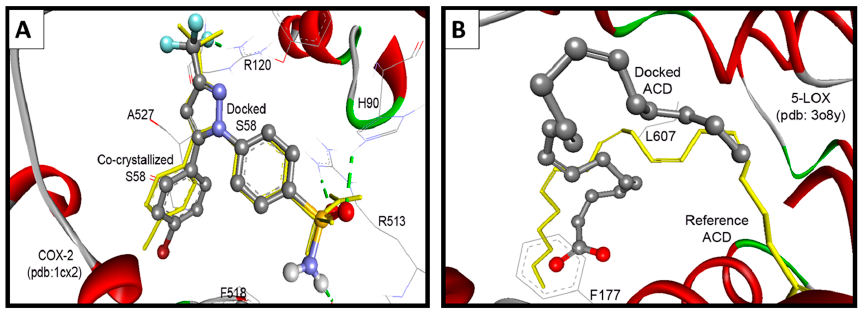
Figure 9. ( A ) Validation of the performance of AutoDock program by docking of the native co-crystallized ligands S58 into COX-2; ( B ) Validation of the performance of AutoDock program by docking of arachidonic acid into 5-LOX.